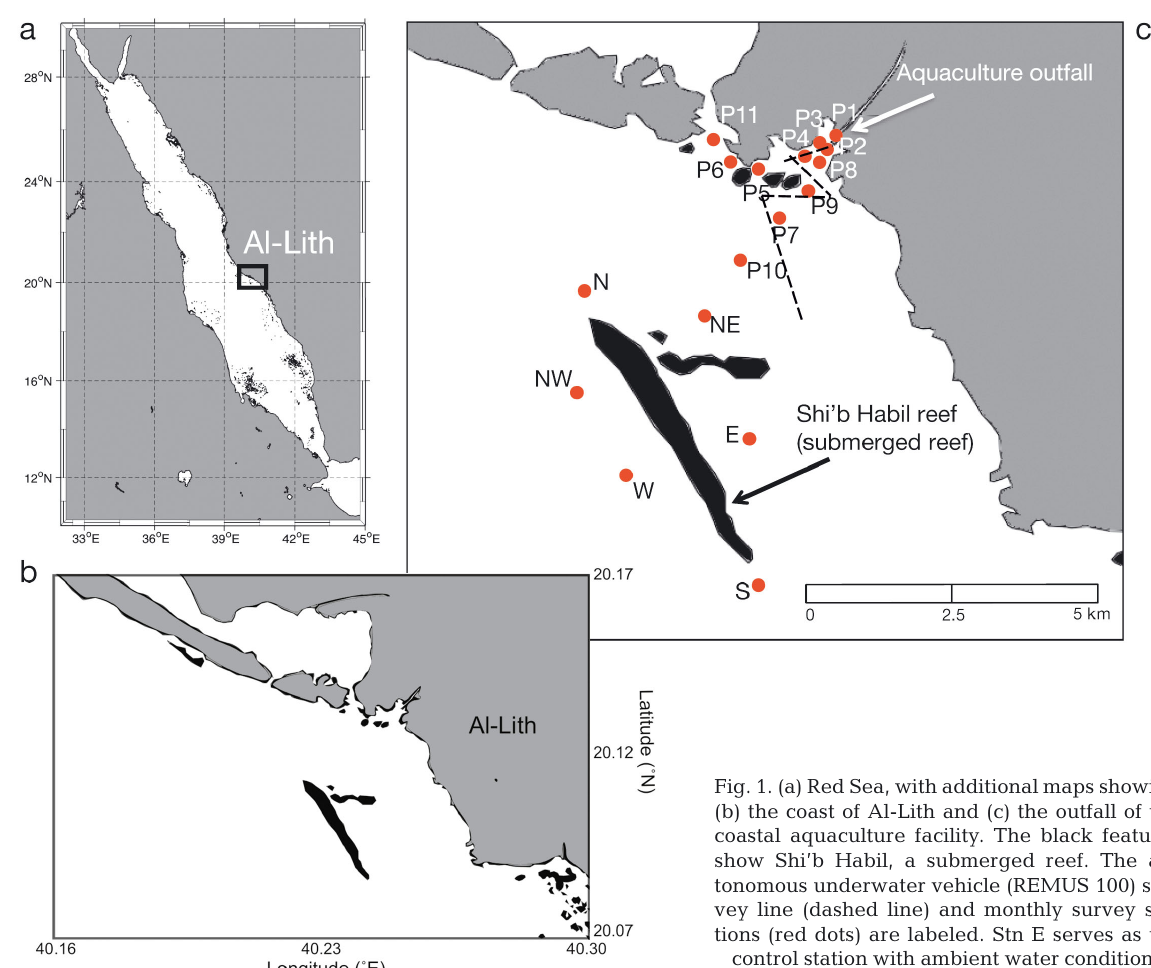
Fig. 1. (a) Red Sea, with additional maps showing (b) the coast of Al-Lith and (c) the outfall of the coastal aquaculture facility. The black features show Shi’b Habil, a submerged reef. The au- tonomous underwater vehicle (REMUS 100) sur- vey line (dashed line) and monthly survey sta- tions (red dots) are labeled. Stn E serves as the control station with ambient water